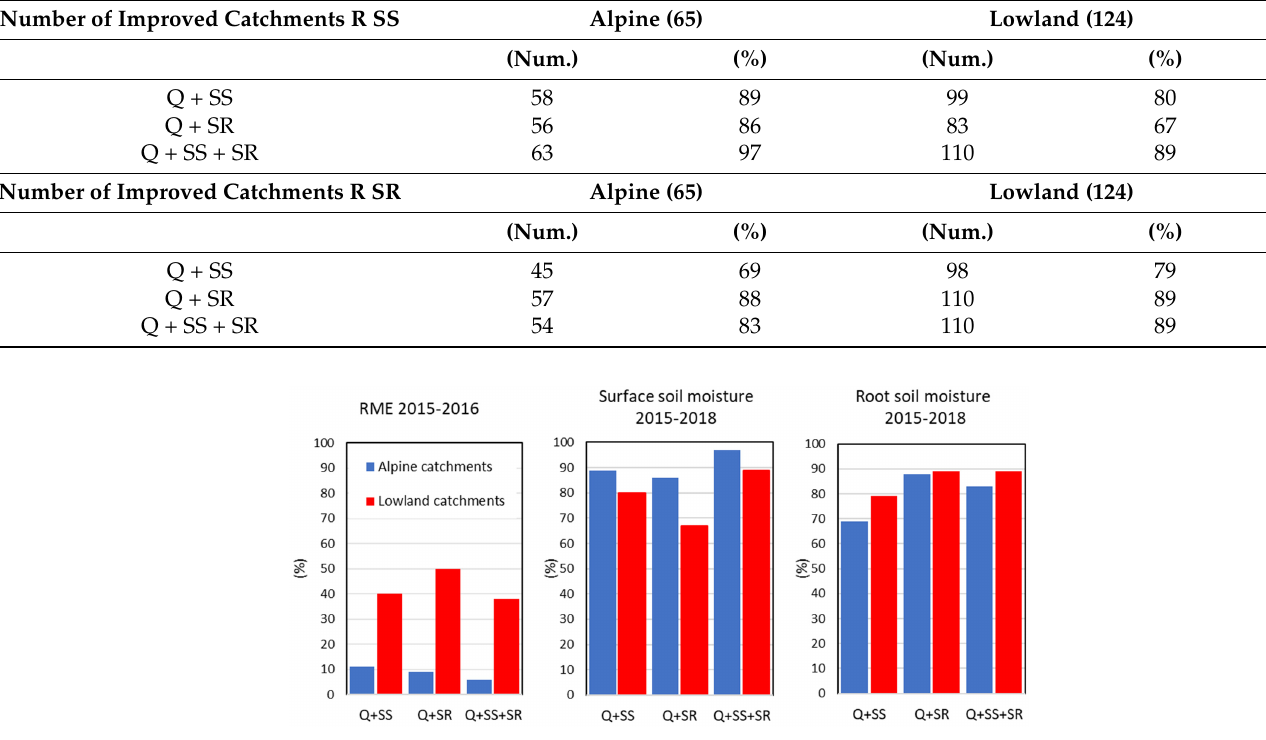
Figure 6. Percentage of Alpine and Lowland catchments for which Q + SS, Q + SR and Q + SS + SR led to improvement compared to Q, between the simulated and measured surface and root soil moisture in the validation periods 2015–2016 and 2015–2018, respectively the (blue) Alpine catchments and (red) Lowland catchments. Table 8. Correlation coefficients between the simulated and measured soil moisture in the surface and root soil layers for 189 catchments in the validation period 2015-2018, and comparison of the number of improved Alpine (65) and Lowland (124) catchments in the correlation coefficients.